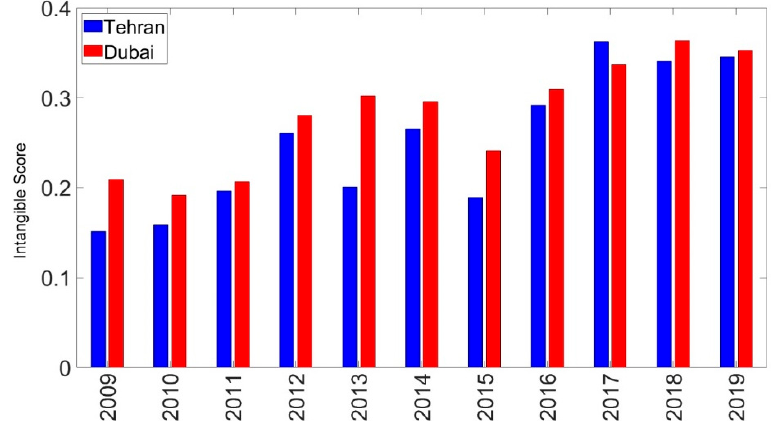
Figure 6. The exhibitions of new arts in both Tehran and Dubai, 2009–2019.